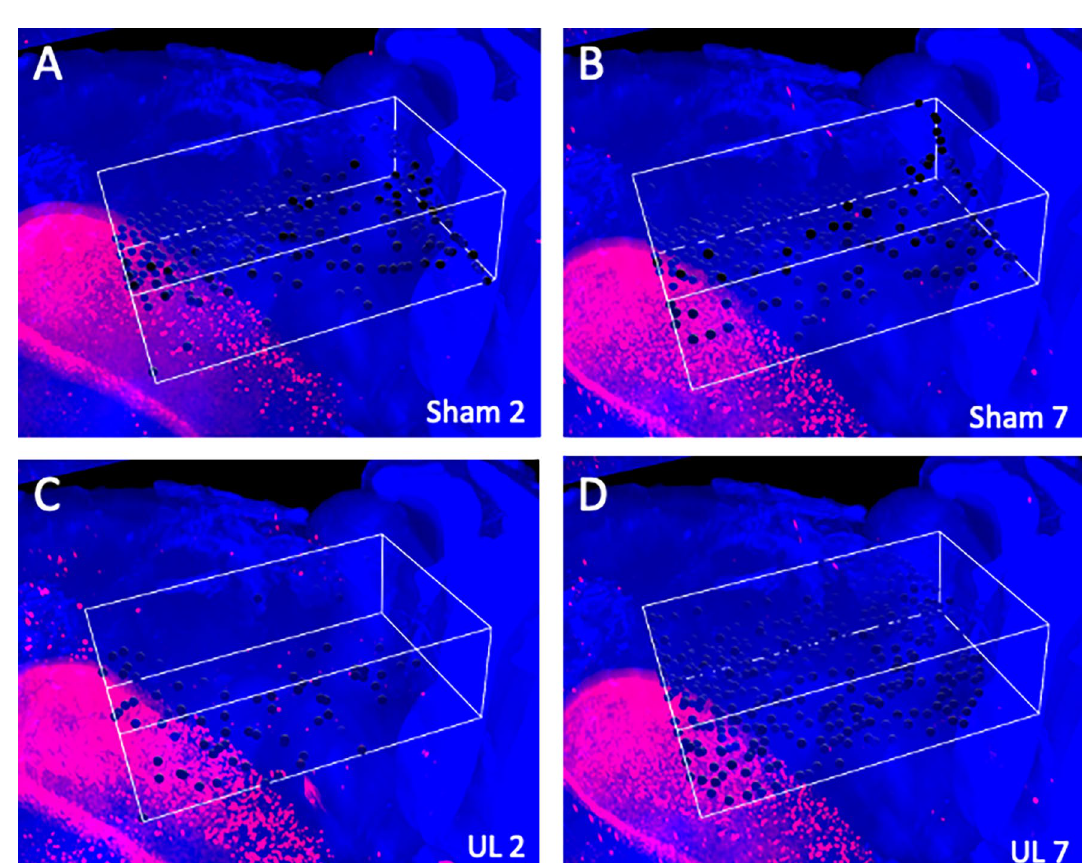
Figure 4. Magnified images of V1. Representative images of activated neurons in box-shaped 3D ROIs set in V1. The black dots indicate automatically-selected activated neurons inside the 3D ROIs. ( A ) Images obtained 2 days after sham surgery. ( B ) Images obtained 7 days after sham surgery. ( C ) Images obtained 2 days after unilateral (left) labyrinthectomy (UL). ( D ) Images obtained 7 days after